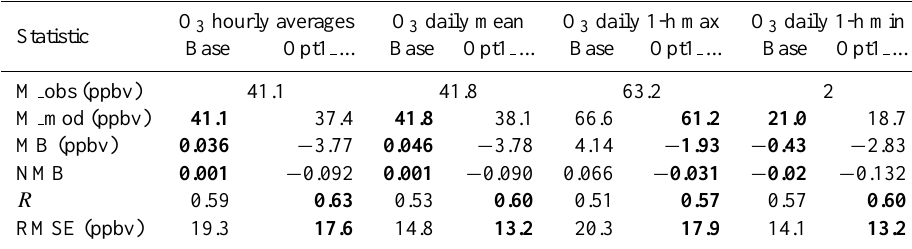
Table 4. Ozone statistics for 10 BAQS-Met and OME surface ozone monitoring sites in southern Ontario during the summer of 2007, comparing Base Case and Opt1 Dyn Extrap2 Wosp simulations to observations, 2.5km grid spacing domain. The run with the better value is shown in bold face, for each metric. M obs: mean observed value, M mod: mean model value, MB: mean bias, NMB: normalized mean bias, R : correlation coefficient, RMSE: Root Mean Square Error.